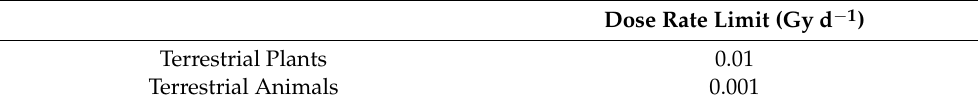
Table 1. DOE dose rate criteria.